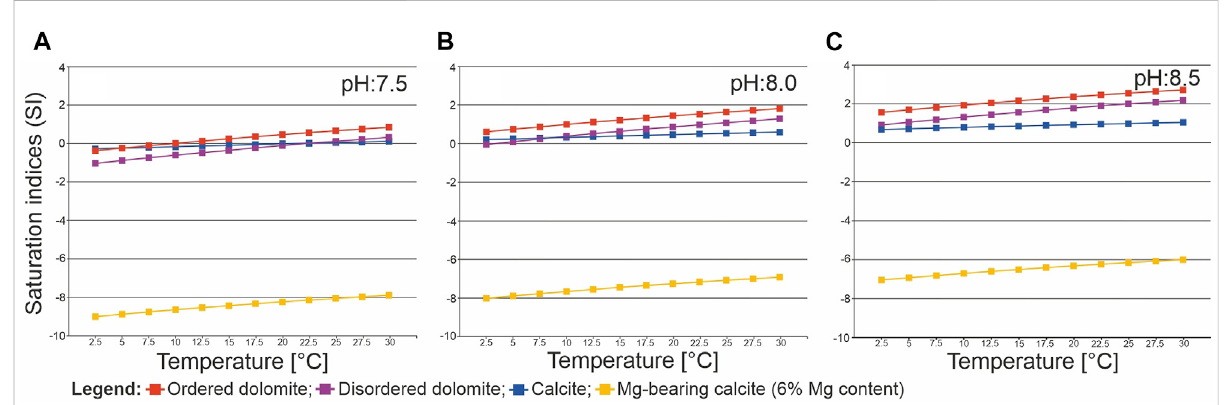
FIGURE 10 CalculatedsaturationindicesforMg-bearingcalcite(withacompositionCa 0.94 Mg 0.06 CO 3 ),calcite,disordereddolomiteandordereddolomite, asafunctionoftemperatureandconsideringatypicalLakeBalatonwaterchemistry,atthreedifferentpHvaluesthatareroughlyrepresentativeof (A) the sediment, (B) the sediment-water interface, and (C) the water